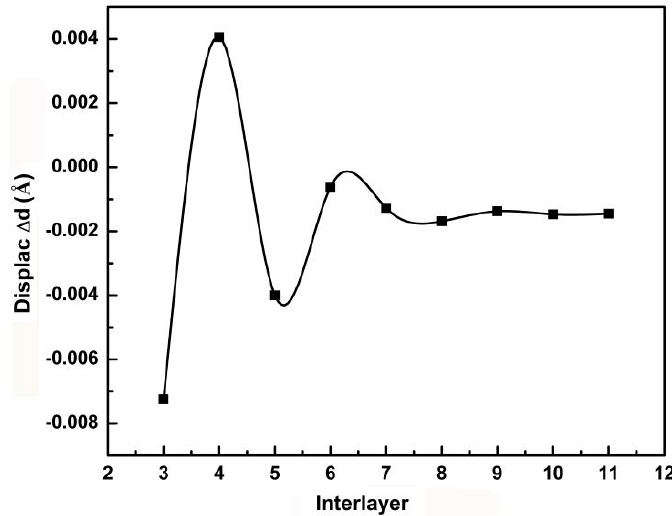
Figure 2. Change in interlayer distance as function of interlayer number in Nb (100) surface model.